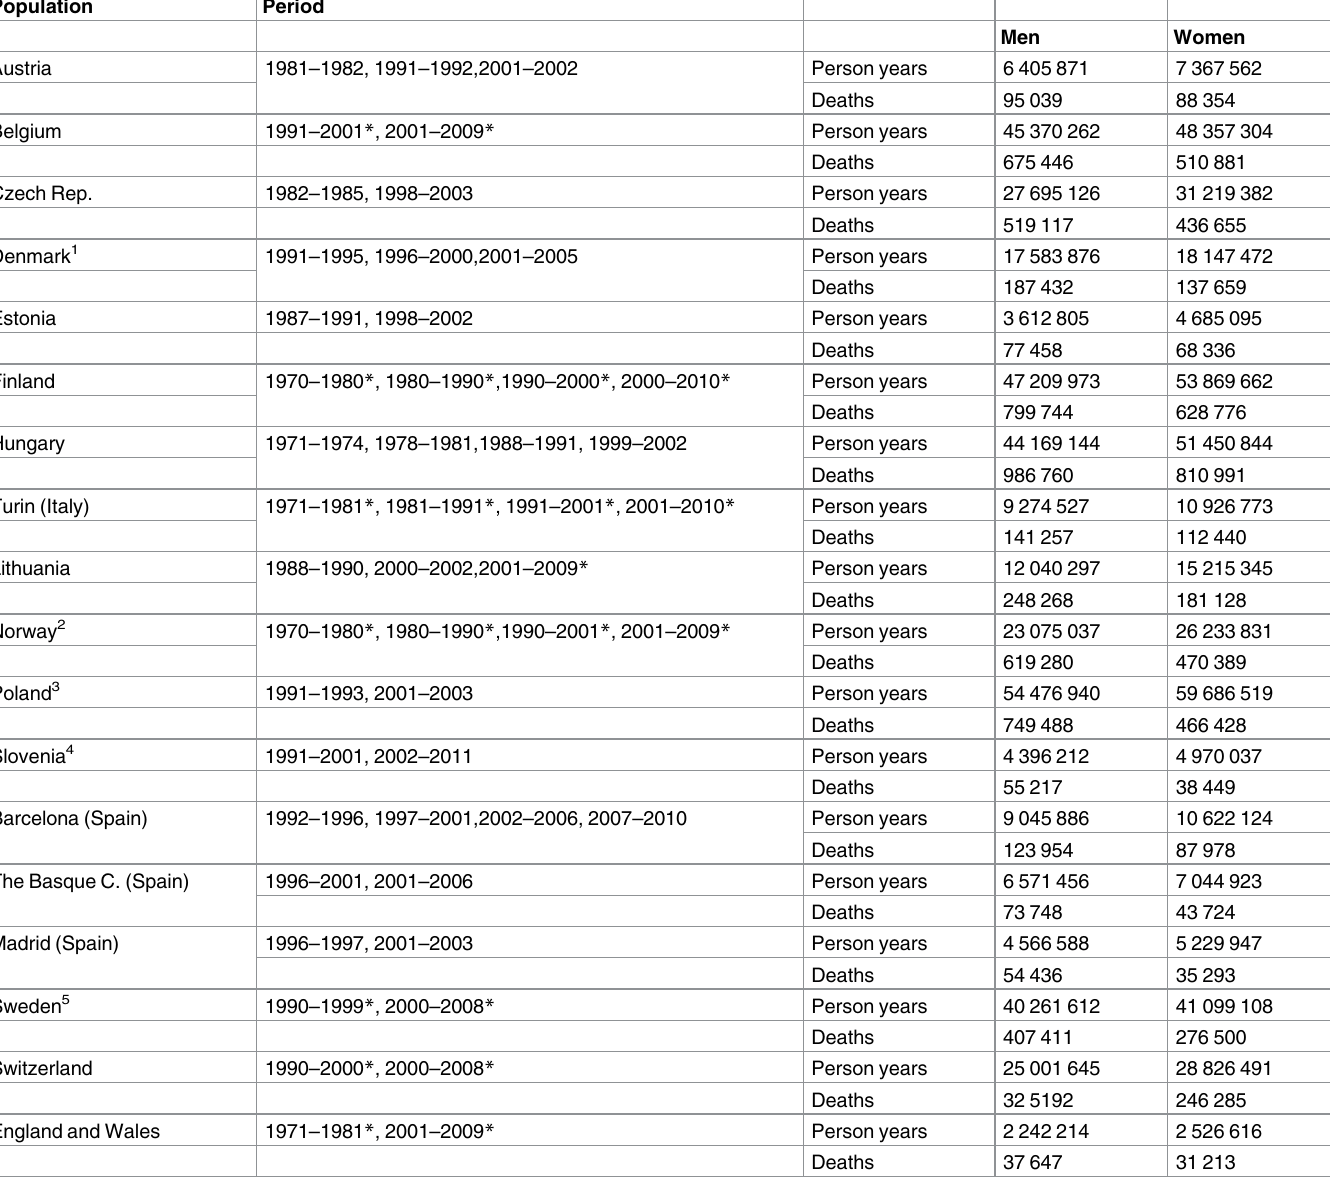
Table 1. Overview of available data, men and women 30–84